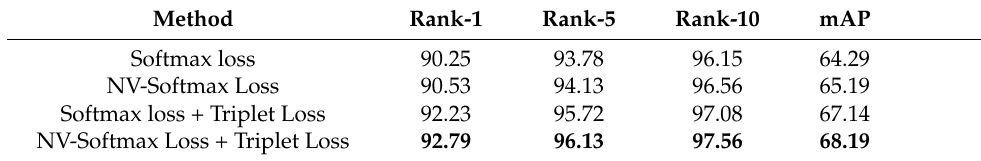
Table 4. Ablation experiments on VeRi.